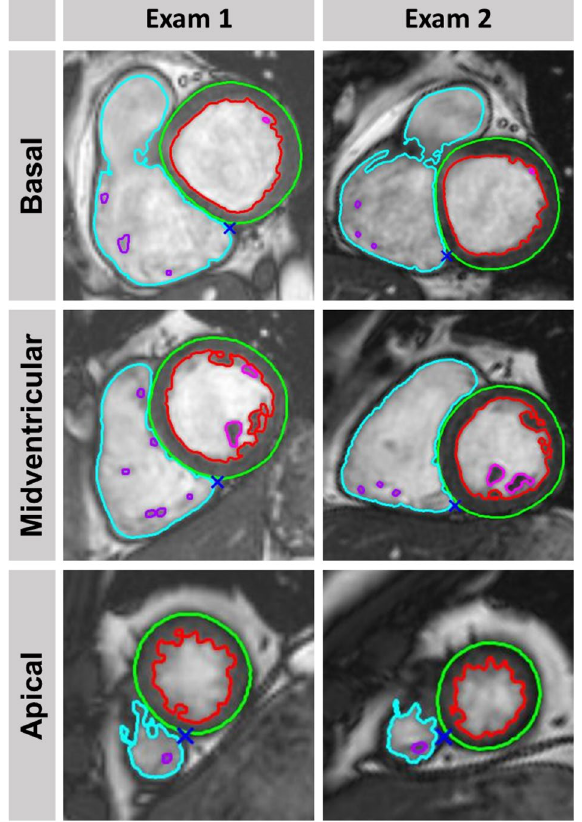
Figure 1. Fully automated biventricular segmentation. The figure depicts automated biventricular volume assessments for a representative volunteer at the basal, midventricular and apical level at baseline MRI (Exam A) and follow-up MRI (Exam B). Higher inter-study variability may potentially be induced by the basal segmentation in the example.